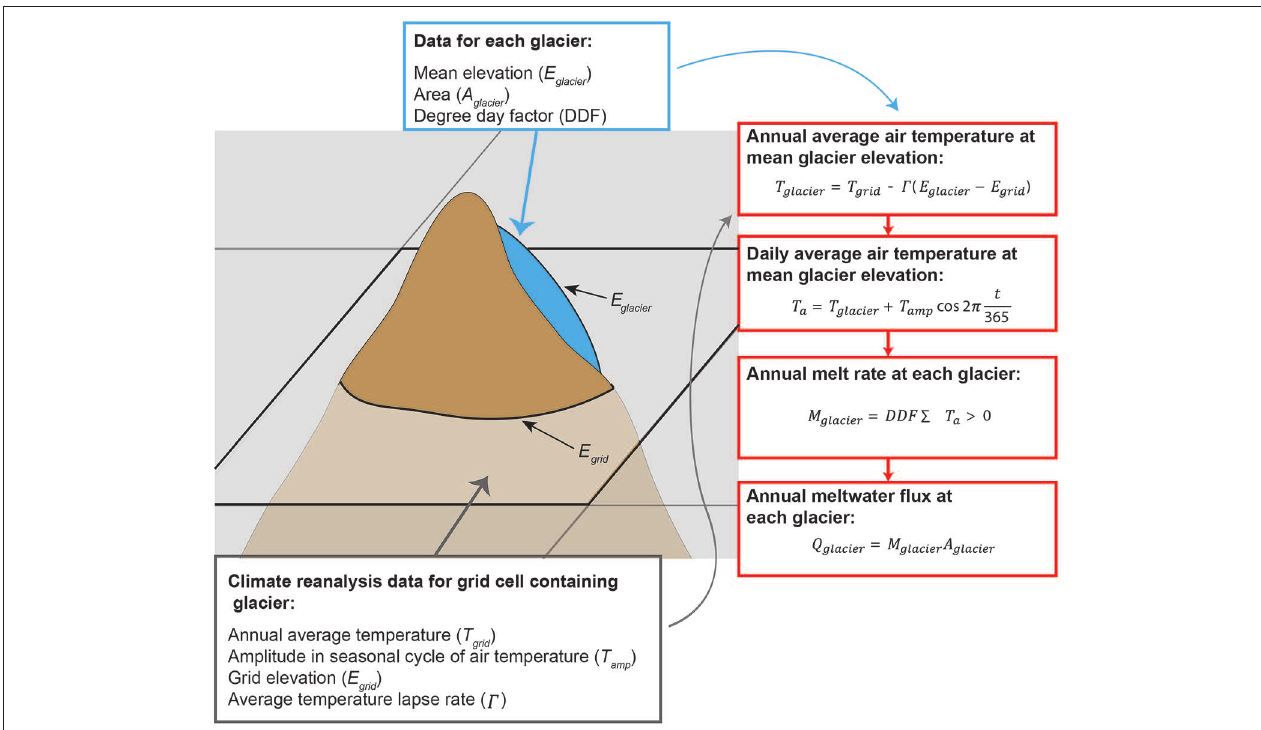
FIGURE 3 | Schematic illustration of the data inputs and calculations used to derive the final meltwater flux at each glacier. The gray, background grids illustrate a coarse reanalysis grid. The cartoon mountain with a blue glacier illustrates the location of the glacier relative to these reanalysis grids. The gray and blue boxes contain a list of the data required as input into the series of equations used to calculate meltwater flux (outlined in red boxes).